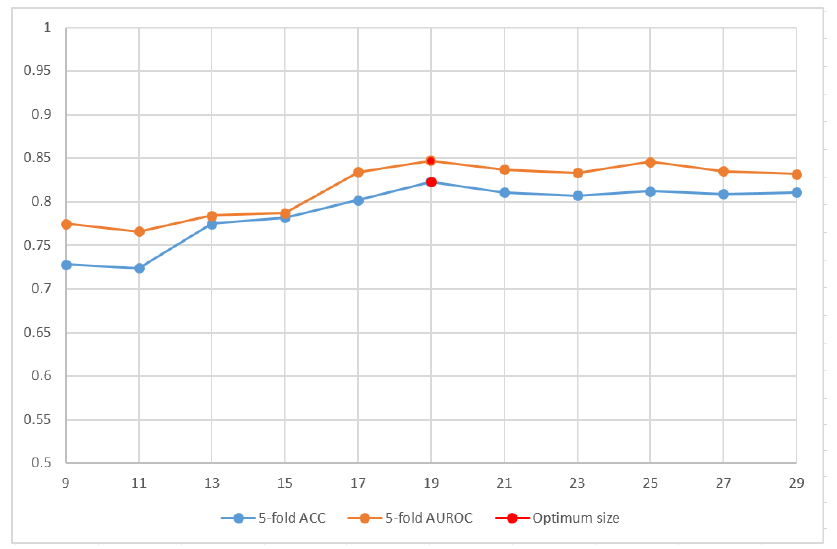
Figure 2. Performance analysis of the model using multiple window size through 5-fold